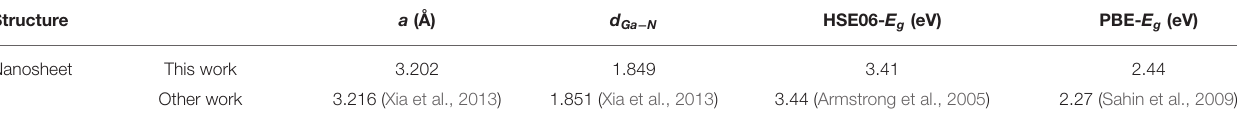
TABLE 1 | The obtained lattice constant a , bond length d Ga